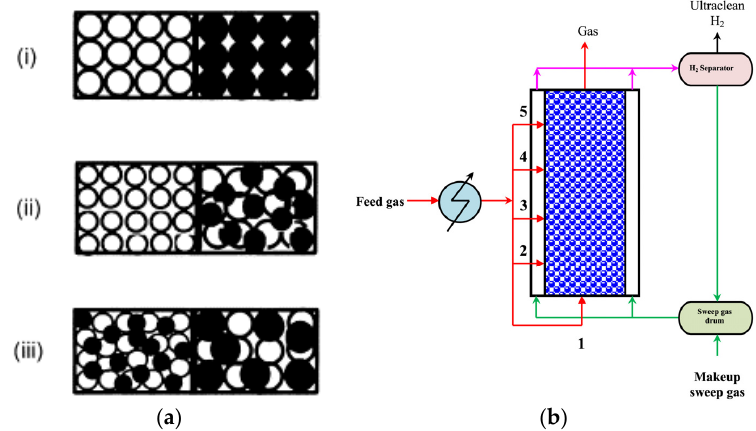
Figure 17. Two types of membrane reactor structures: ( a ) structured catalyst bed membrane reactor with different catalyst configurations [53]; ( b ) FBMR with distributed injection feed [61].